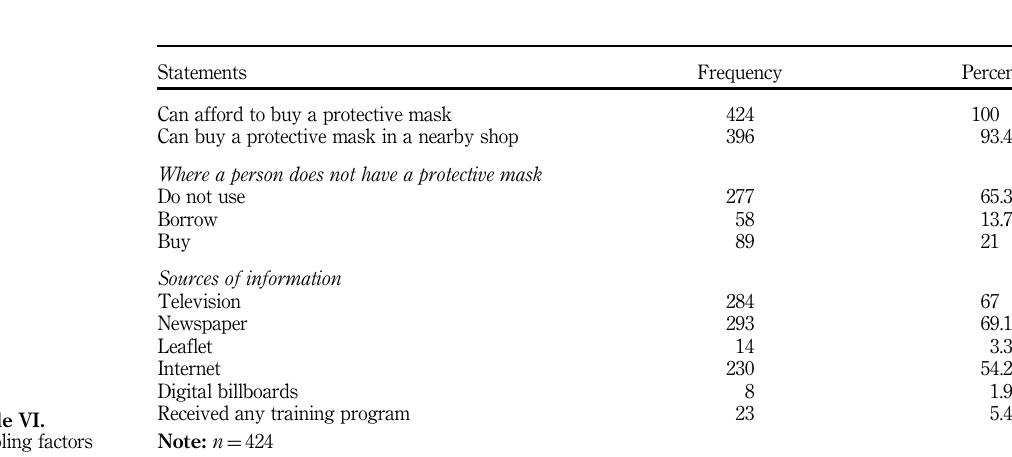
Table V. Availability of social support for information about protective practices and information about inhalable particulate matter and its health